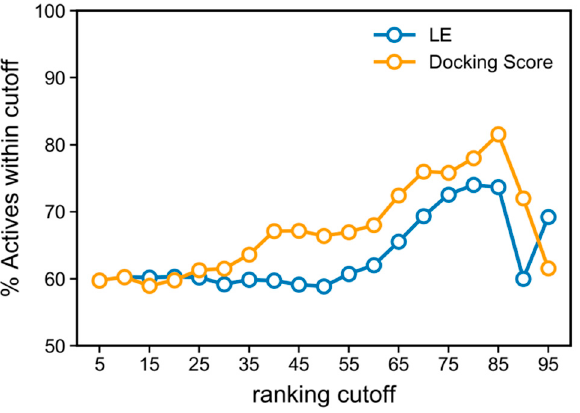
Figure 6. Enrichment curve with docking score and LE, applied to the ChEMBL dataset.